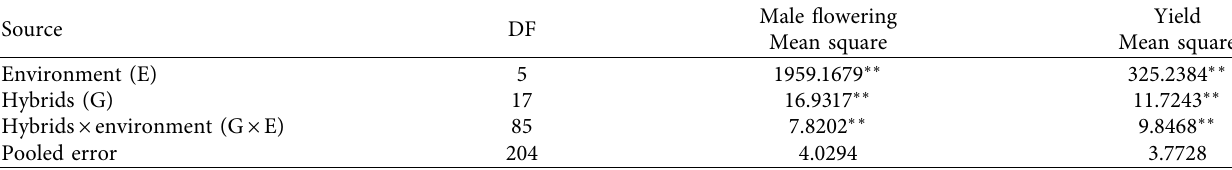
Table 2: Combined analysis of variance for earliness and yield of sweet corn hybrids.